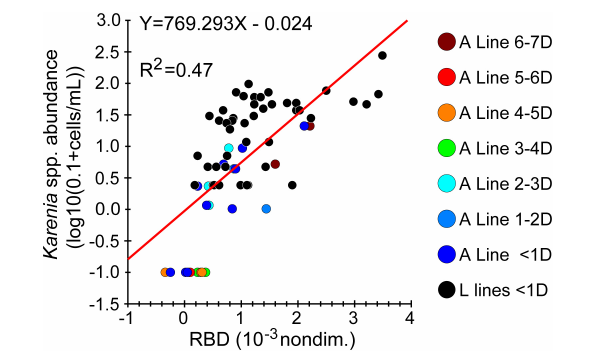
FIGURE 11 | Scatter plots of Karenia abundance at 10-m depth along the A Line and L lines. Data collected from the L lines (black closed circles) were measured within 1 day (“ < 1D”) of an observation by Sentinel 3. Data collected from the A Line are colored according to time interval (in days) between the abundance measurement and an observation by Sentinel 3, where the longest interval was 7